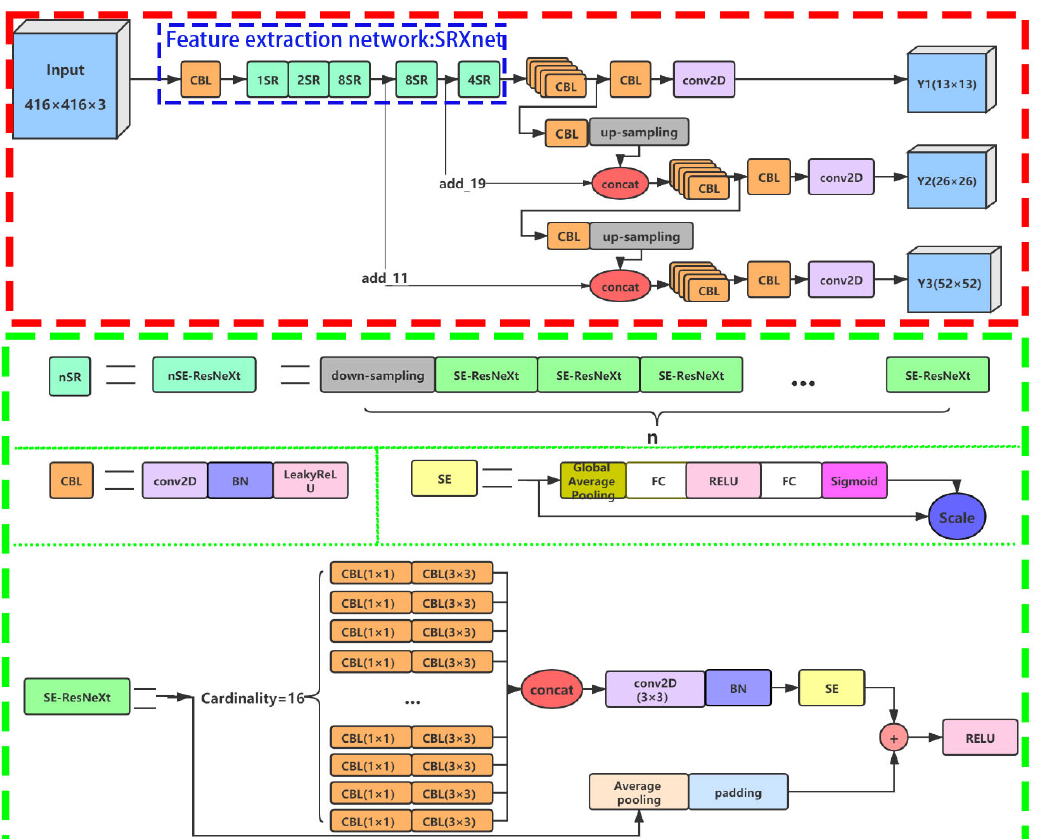
Figure 8. Structure of YOLO-S-CIOU. The part in the red dashed box represents the overall structure of YOLO-S-CIOU; the part in the green dashed box represents the 4 substructures of YOLO-S-CIOU; and the part in the blue dashed box represents SRXnet. Modules with the same color represent the same operation. CBL is a structure containing a convolution layer (conv2D), a batch normalization (BN) layer, and a LeakyReLU layer. Concat represents concatenate.